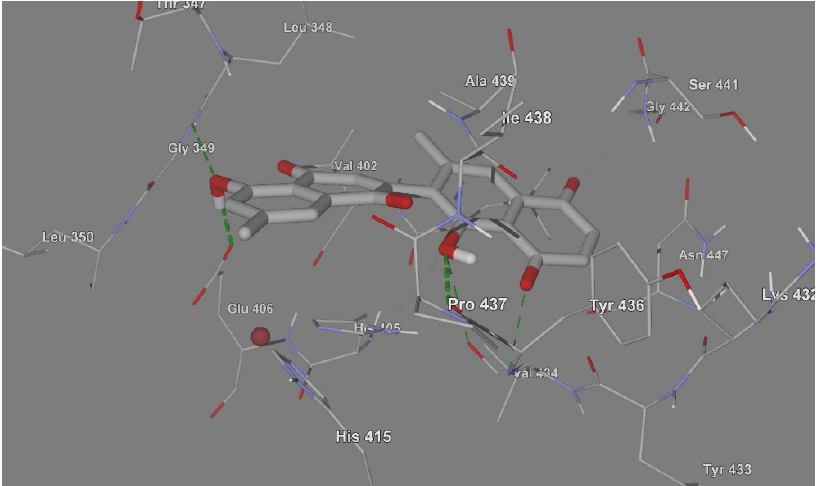
Figure 6. Predicted binding mode of lowest energy conformation of diospyrin inside the active site of TNF ‐ α ‐ converting enzyme (TACE).